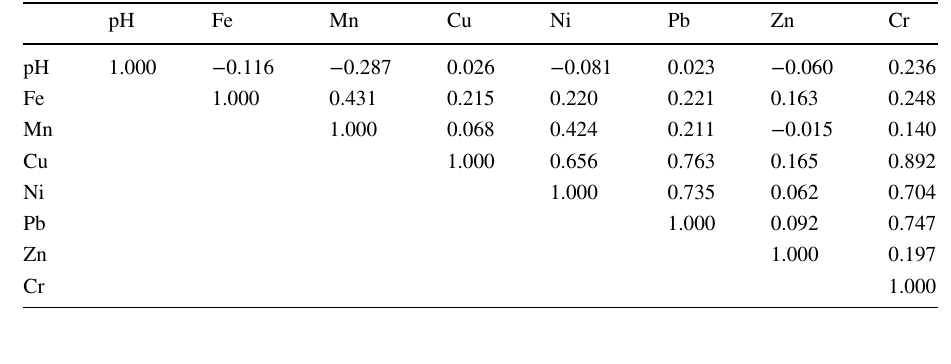
Table 8 Correlation of various heavy metals in the groundwater during post-monsoon